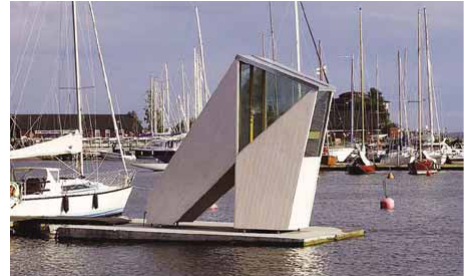
archit. biuras „Jarmund/Vigsnaes AS“, 2010 m. Fig. 27. Dune house in Sufolk, United Kingdom, archit. office “Jarmund/Vigsnaes AS”,